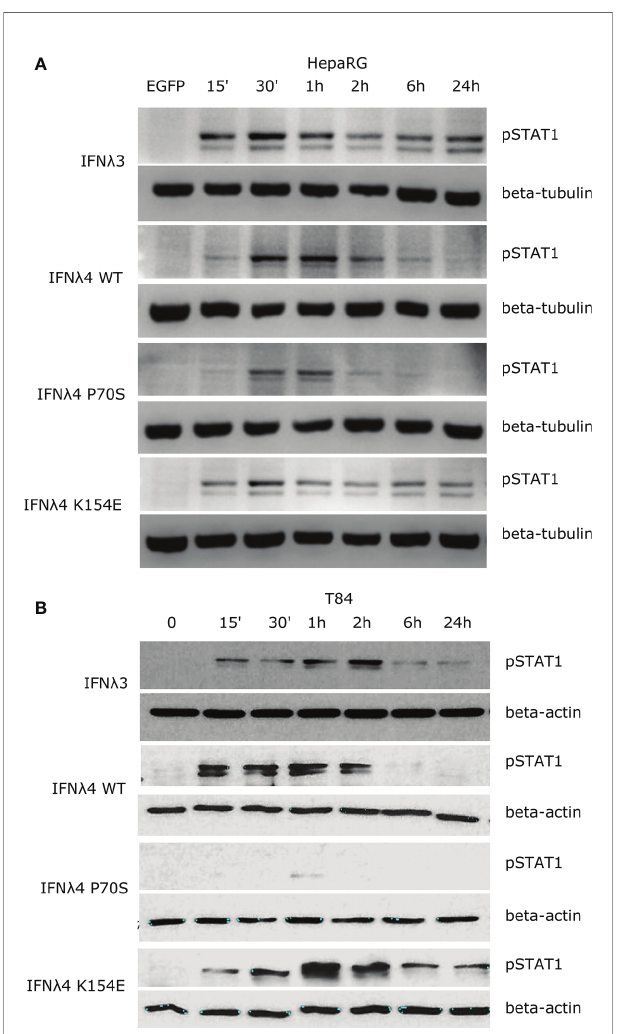
FIGURE 1 | IFN l s each have a distinct kinetic of STAT1 phosphorylation. HepaRG (A) and T84 (B) cells were incubated with IFN l s (IFN l 3-HiBiT, IFN l 4-HiBiT): WT, P70S, and K154E for the indicated times and the levels of pSTAT1 were assayed by immunoblot. Beta-tubulin (HepaRG) or beta-actin (T84) served as loading controls. EGFP (A) or timepoint 0 (B) serves as a conditioned media control. Representative images of two or three replicates are shown from at least two independent protein